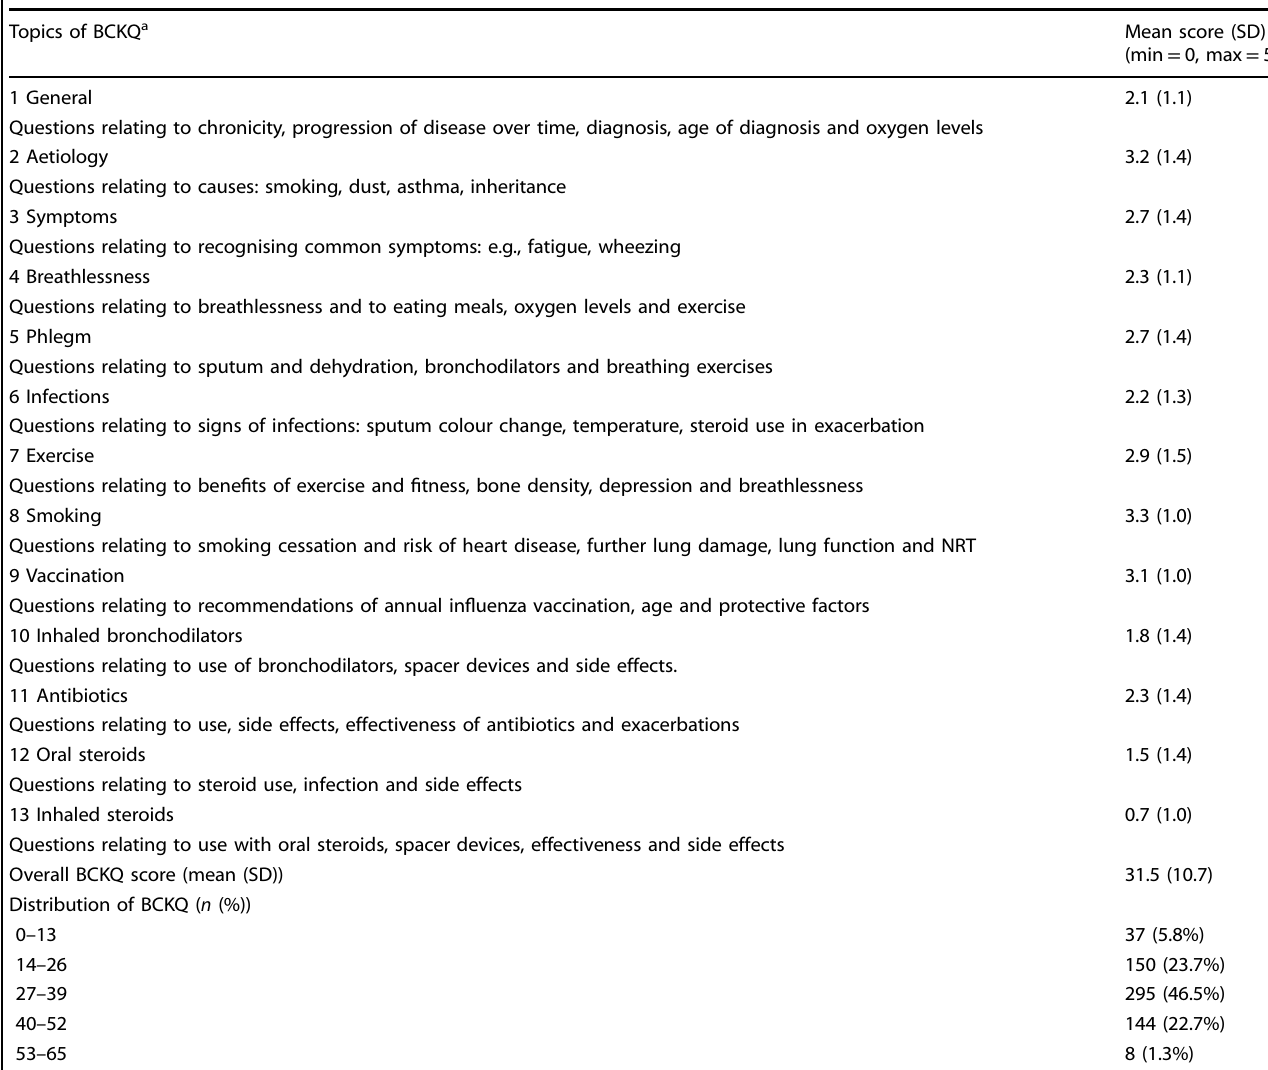
Table 3. Self-management behaviours: Bristol COPD Knowledge Questionnaire (BCKQ) Topics of BCKQ